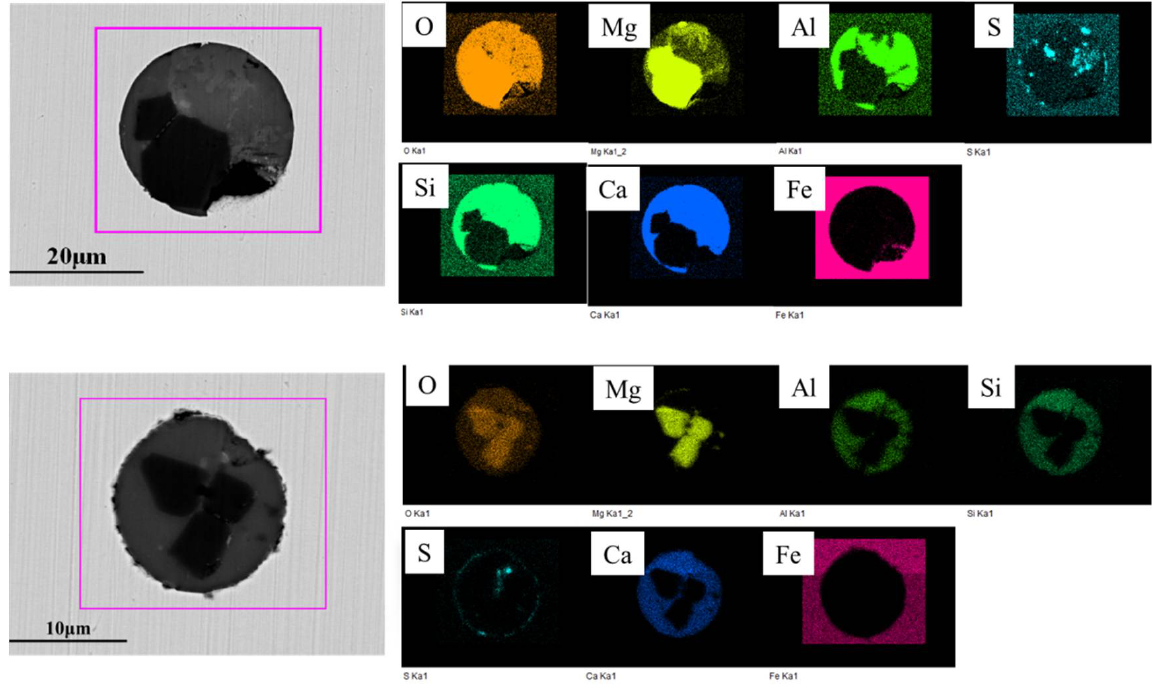
Figure 8. Morphology and composition of typical inclusions in billet.